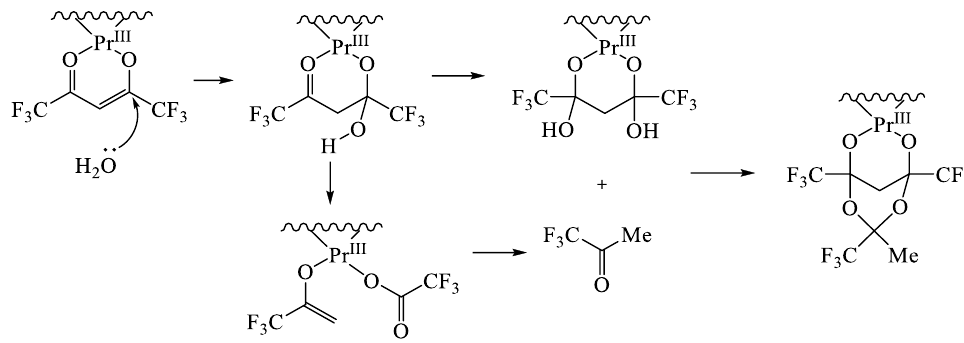
Figure 41. Crystal structure of [Pr(hfac) 2 (CF 3 -diol)Cu(Hbdmap) 2 (tfa)] ( 93 ) [131]. CF 3 groups are transparent for clarity. The cif has been retrieved from CCDC. CCDC number is 1232922.